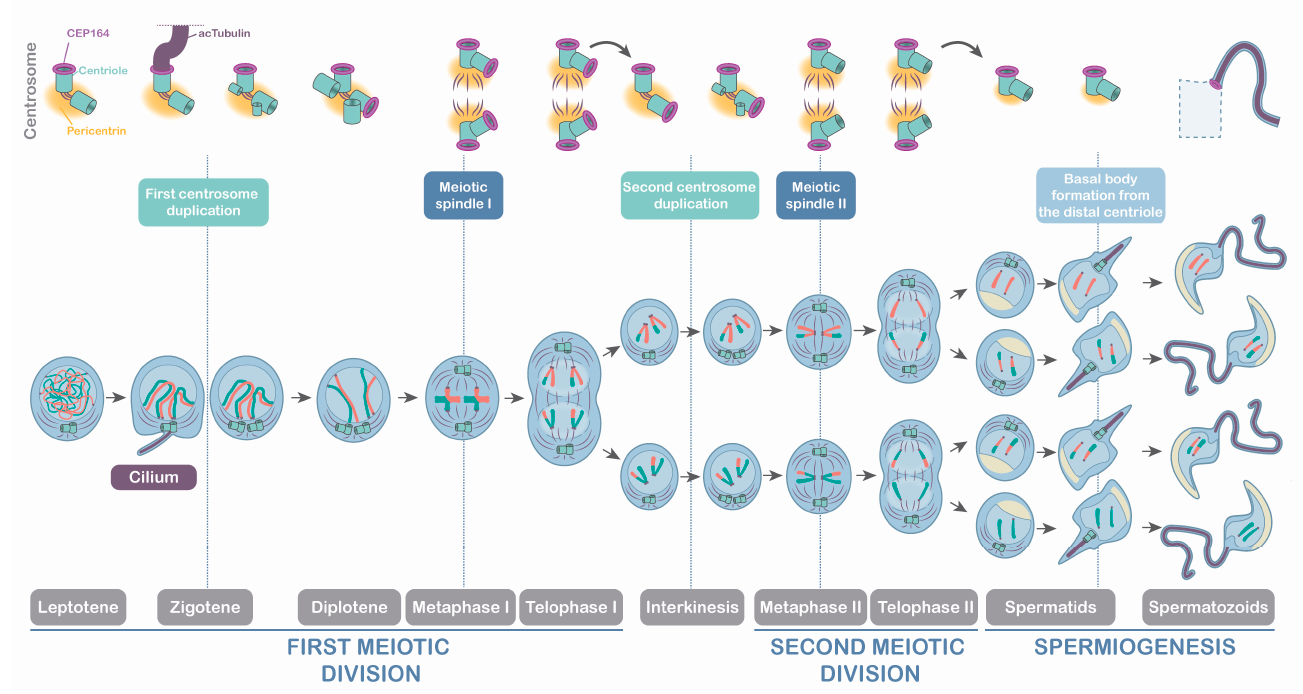
Figure 8. Schematic representation of the meiotic stages in relation to centrosome dynamics. Meiosis progression showing the centrosomal events (centrosome duplication I and II and formation of meiotic spindle I and II). Ciliogenesis and flagelogenesis events are represented: centrosome duplication occurs at zygotene transition and interkinesis; the formation of primary cilia occurs at zygotene transition; and flagellum is formed in spermatids. The distribution of centrioles, pericentriolar matrix (Pericentrin), and distal appendages (CEP164) are represented through both meiotic divisions. Primary cilia at zygotene and flagella at spermatids are shown with acetylated tubulin (AcTub). A schematic representation of spermiogenesis shows the formation of the acrosome and the flagella of the spermatozoids (dotted box).